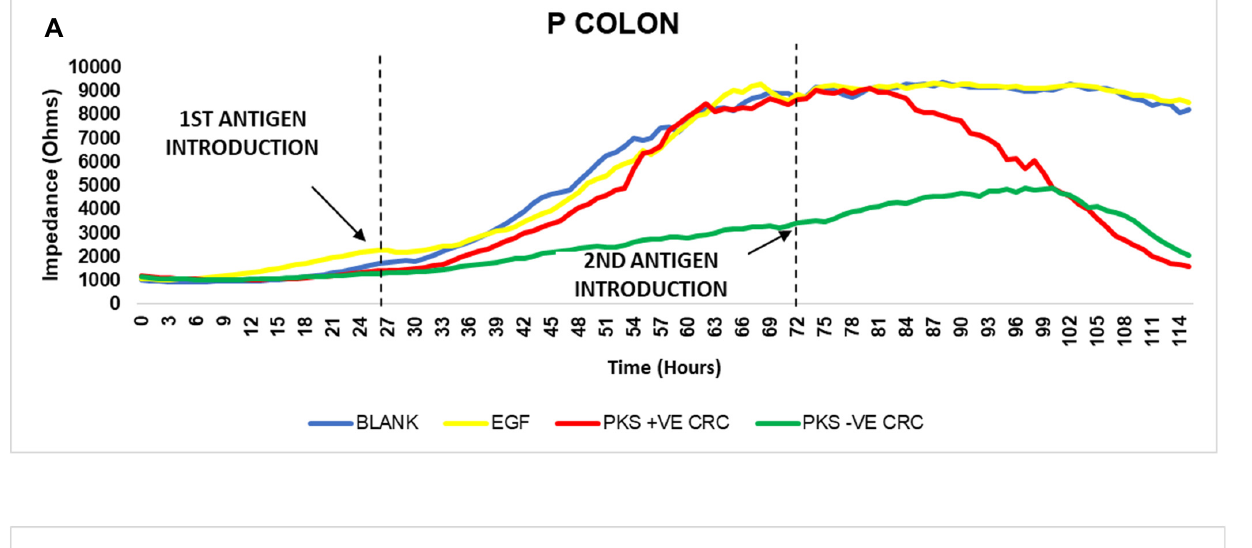
Figure 9B: Enhancement of Cell Proliferation Upon Exposure to K. pneumoniae Antigens